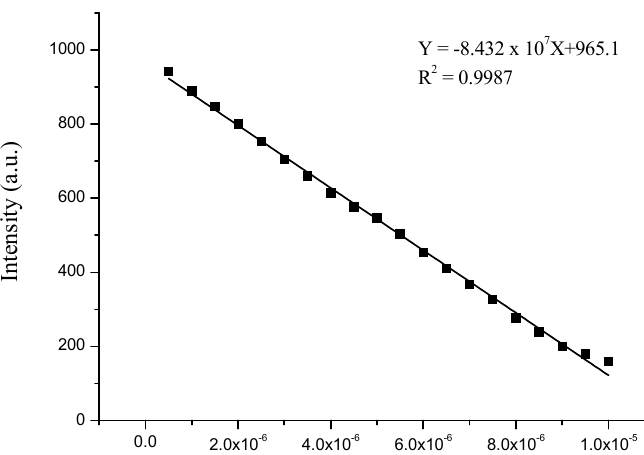
Figure 7. Plot of linear fitting for emission intensity vs. the concentration of Cu 2+ (mol/L) .